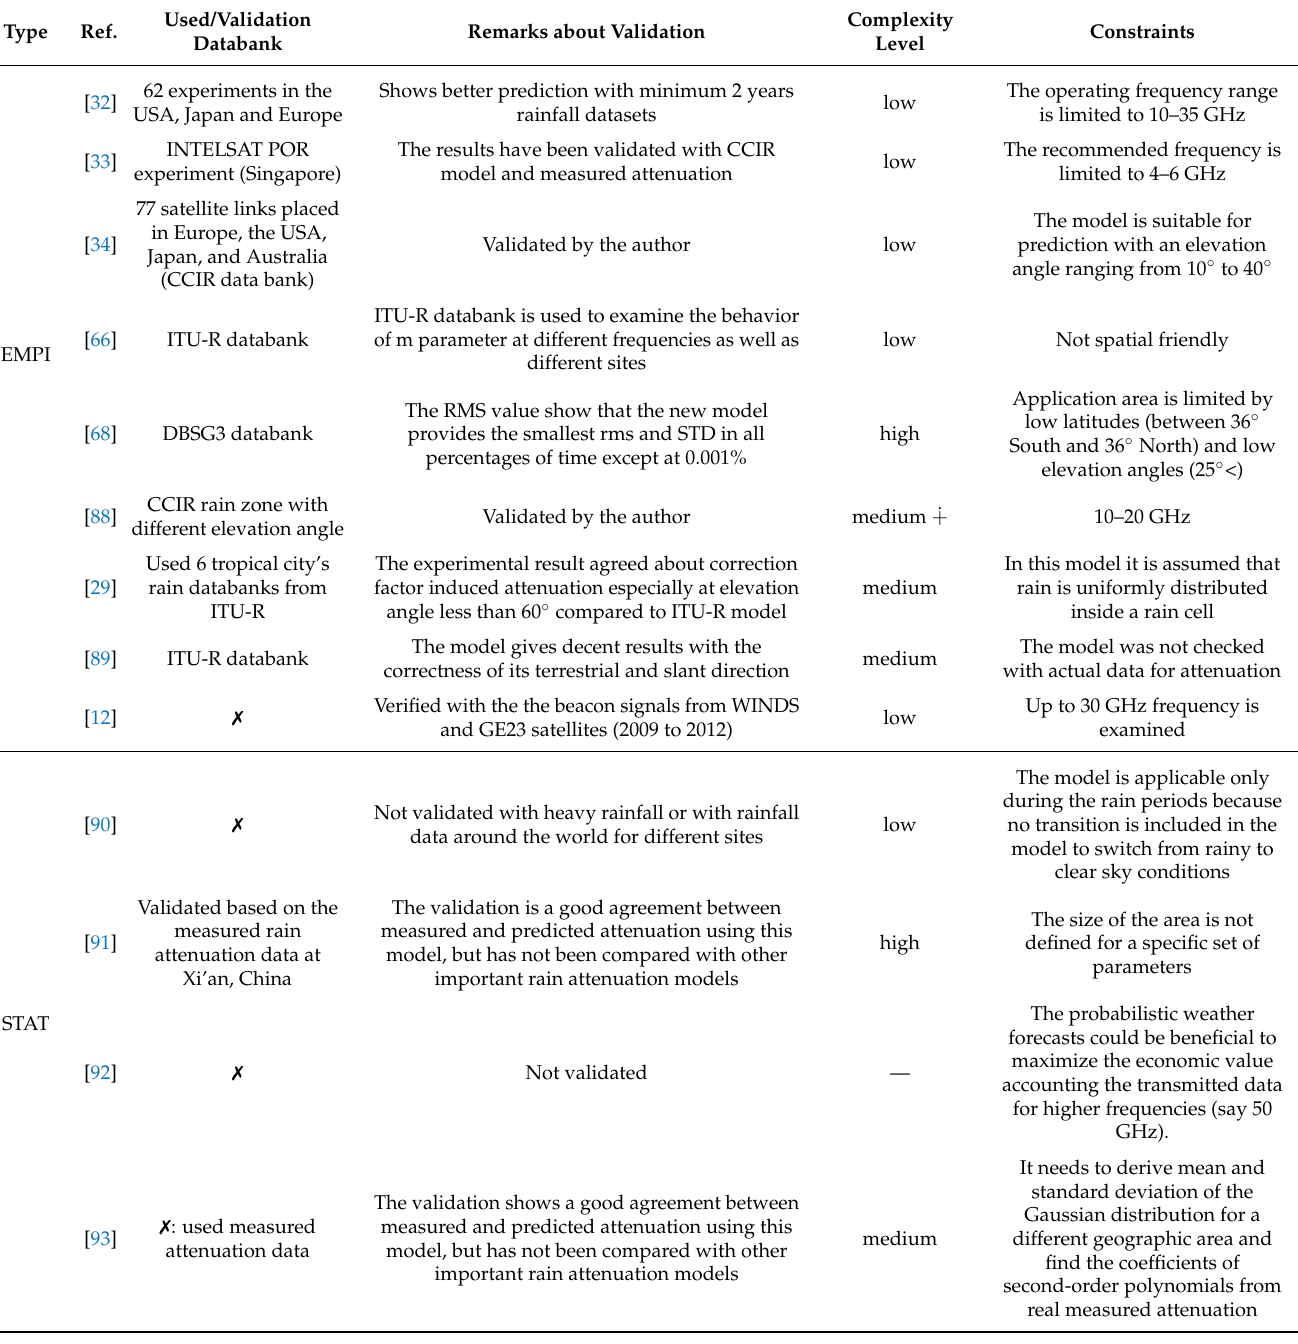
Table 9. Characteristics